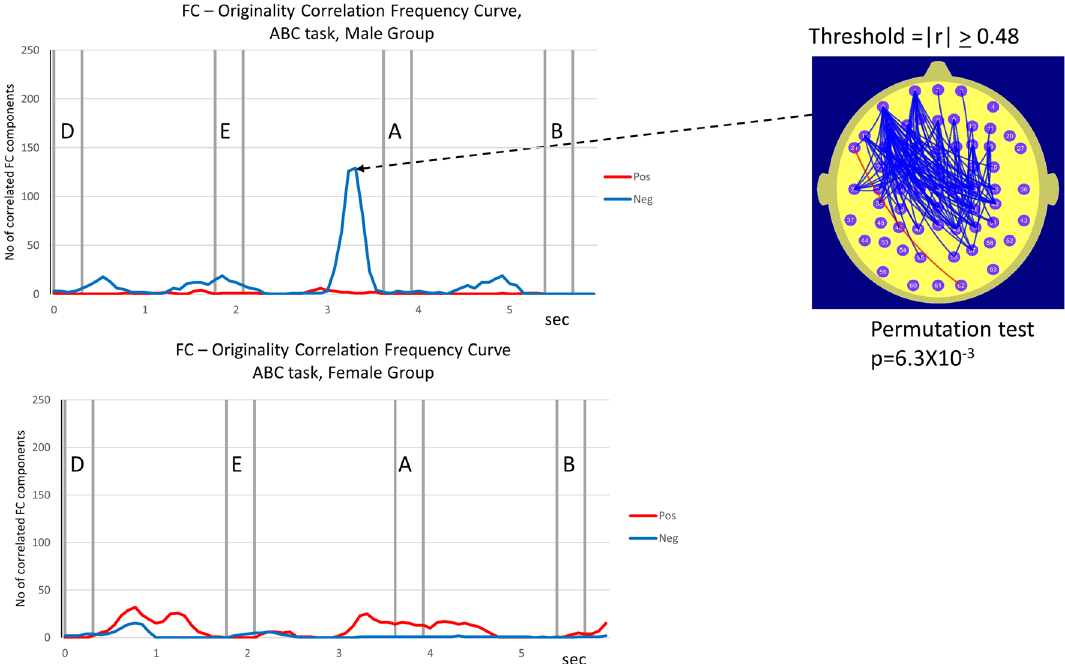
Figure 2. Number and location of electrode pairs where FC was correlated with the Originality score (Or) at the |r|> 0.48 level while the males (top trace) and the females (bottom trace) performed the ABC low demand vigilance task. In the graphs or correlation frequency curves , the blue trace illustrates the number of electrode pairs where FC is negatively correlated with Or (r ≤ -0.48) while the red trace illustrates the corresponding number that is positively correlated with Or (r ≥ 0.48). The topographic map illustrates the FC components correlated with Or (at threshold condition |r|≥ 0.48) at the point in time where the correlation frequency curve peaks. The p value listed under the map is derived using the permutation test and is the probability of observing this number of correlated FC components under the NULL hypothesis. The topographic maps are presented only if the permutation test indicates that the number of correlated FC components is statistically significant at the p ≤ 0.05 level. This level of significance was only observed in the male data. In the case of the female data, the peak of the correlation frequency curve for positive correlations peaks at the point 0.77 s into the trial corresponding to 32 FC correlated with Or at the threshold condition |r|≥ 0.48. The probability of observing this number of correlated FC components is p = 0.06 and thus does not satisfy the criterion for an illustrative topographic map.